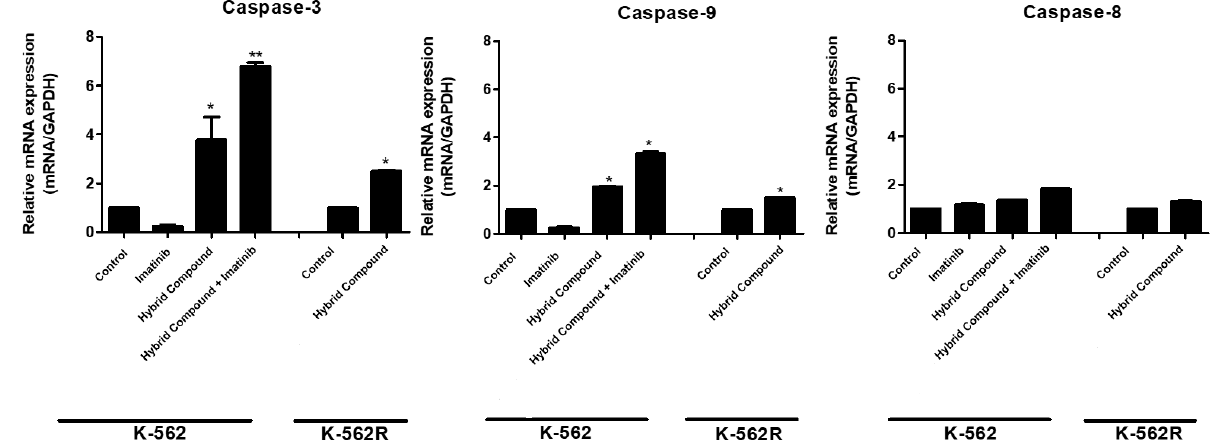
Figure 5. The mRNA expression levels of caspases 3, 9 and 8 were evaluated by qRT-PCR in K-562 cell line treated with imatinib, the hybrid compound and the combination of them, and in K-562R cells after treatment with the hybrid compound. Treatments were performed with respective IC 50 for 48 h. Comparative analysis was performed with the 2 − ∆∆ CT method using glyceraldehyde-3-phosphate dehydrogenase (GAPDH) as the endogenous control. The expression ratios were compared to the control. The values are representative of three different experiments. Data were compared by ANOVA followed by Tukey’s test (* p < 0.05 ** p < 0.01 represents statistical significance).